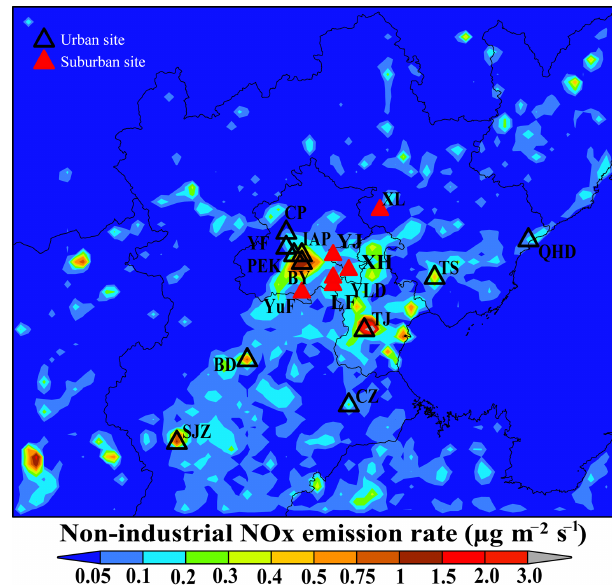
Figure 1. Distribution of the observation stations and non-industrial NO x emission rates in the third model domain (9km resolution) that covers Beijing and its surrounding areas. The non-industrial NO x emission rates (µgm − 2 s − 1 ) are divided into different bins ( < 0.05; 0.01–0.1; 0.1–0.2; 0.2–0.3; 0.3–0.4; 0.4–0.5; 0.5–0.75; 0.75–1.0; 1.0–1.5; 1.5–2.0; 2.0–3.0) and represented by different shaded col- ors. The urban areas with high non-industrial NO x emission rates are marked by the brown and red colors, and the suburban or ru- ral areas with low non-industrial NO x emission rates are marked by the green or blue colors. The 11 urban sites are denoted by the black triangles, and the 6 suburban stations are represented by the red triangles. The abbreviations of the station names are displayed close to the